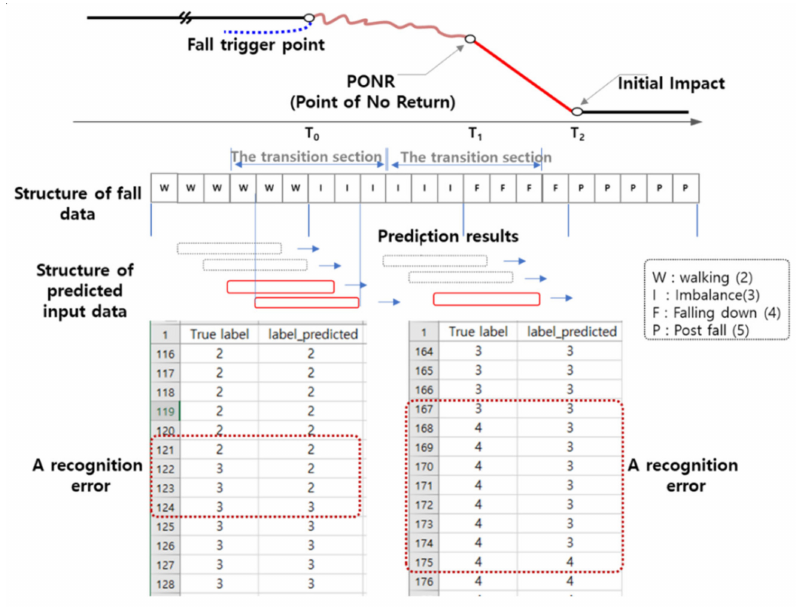
Figure 9. Recognition errors in transition